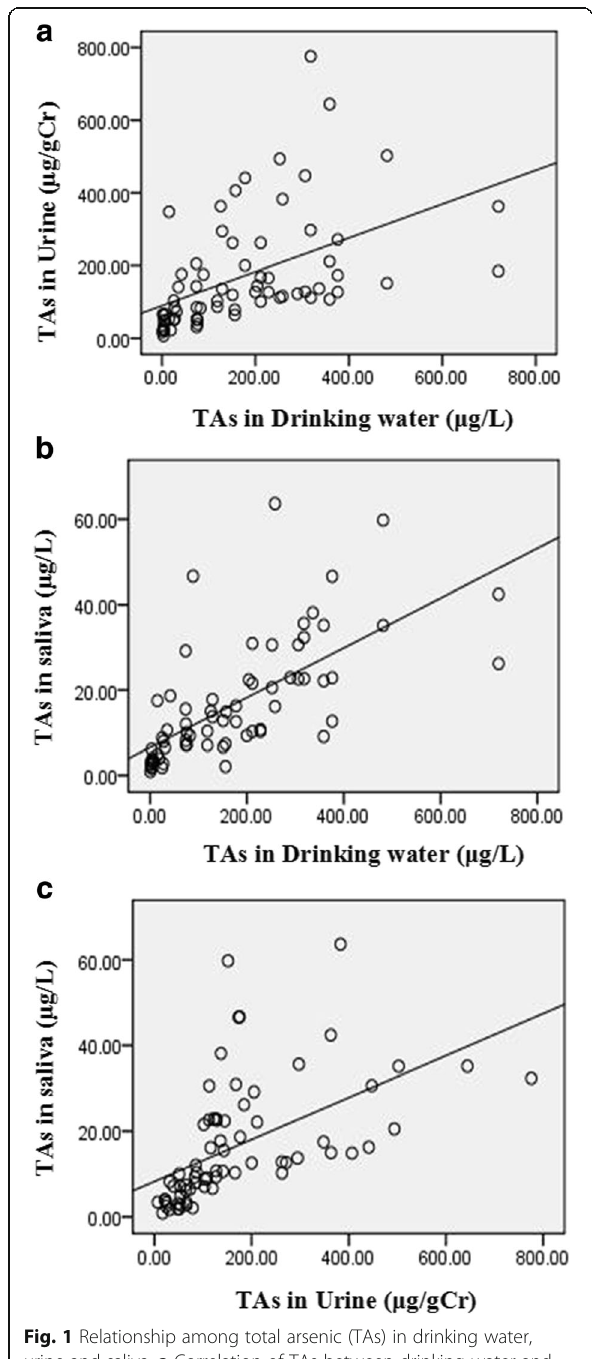
Fig. 1 Relationship among total arsenic (TAs) in drinking water, urine and saliva. a Correlation of TAs between drinking water and urine ( r = 0.686, P < 0.01, n = 70). b Correlation of TAs between saliva and drinking water ( r = 0.674, P < 0.01, n = 70). c Correlation of TAs between urine and saliva ( r = 0.794, P < 0.01, n =